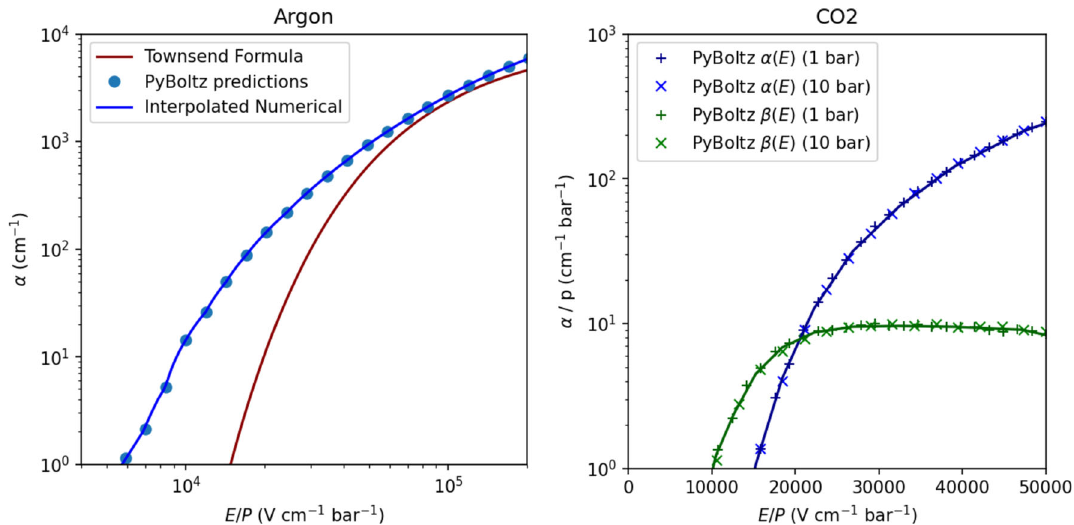
Fig. 1 Left: Comparison of the conventional Townsend approxima- tion for α against the PyBoltz microphysical prediction. The blue line shows the interpolated function which is inverted to use in solu- tion of Eq. 9. Right: PyBoltz calculations of reduced attachment and